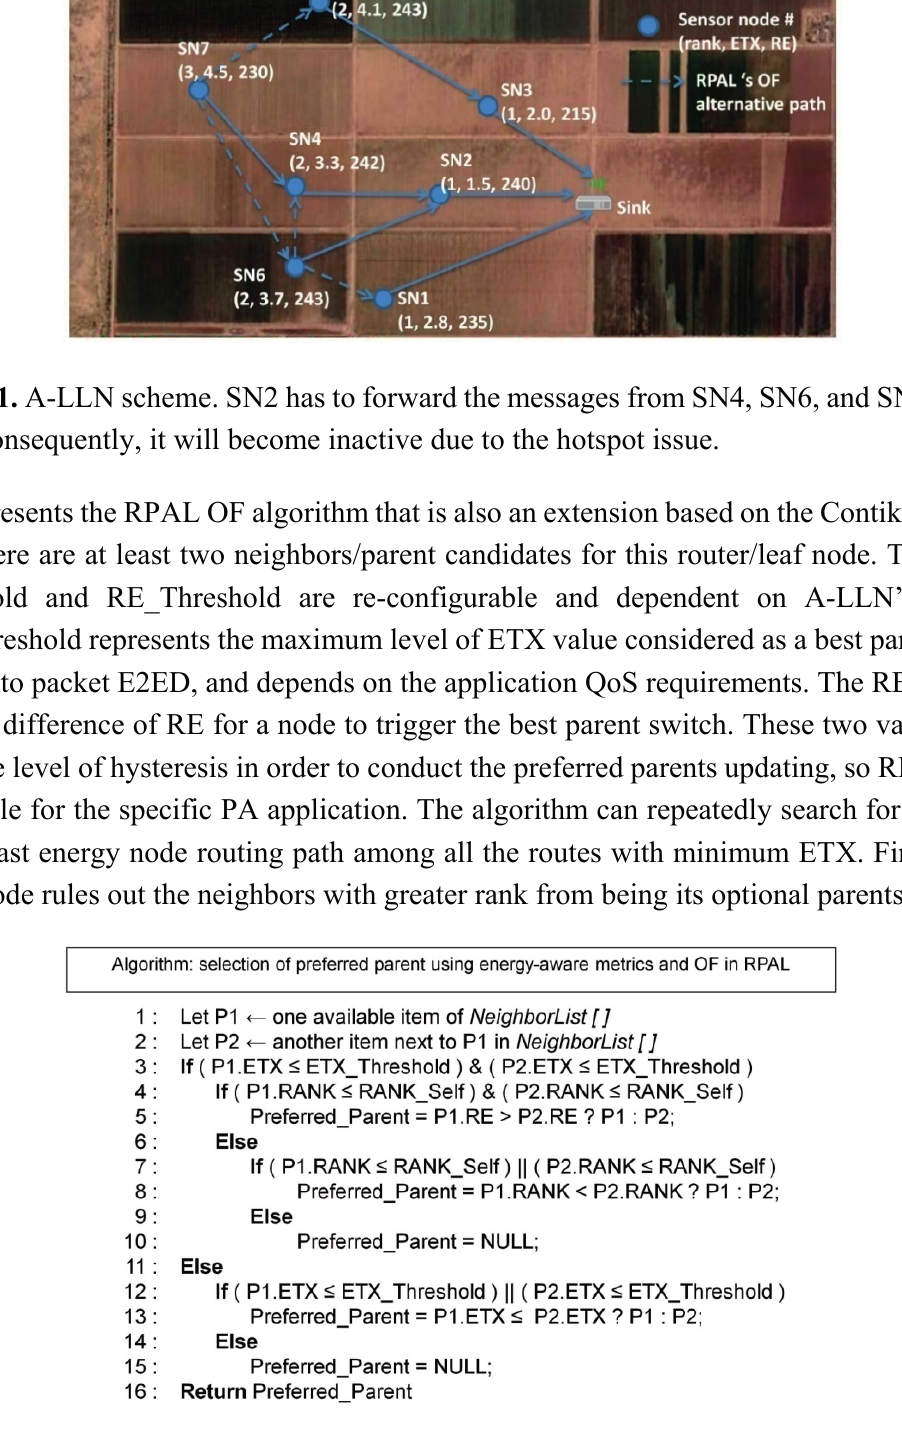
Figure 2. RPAL OF selects the neighbor with the viable ETX and the highest RE to be the preferred